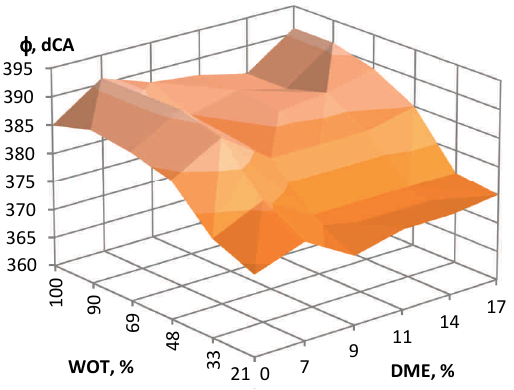
Fig. 14. A point of 50% MFB during combustion process, n = 2500